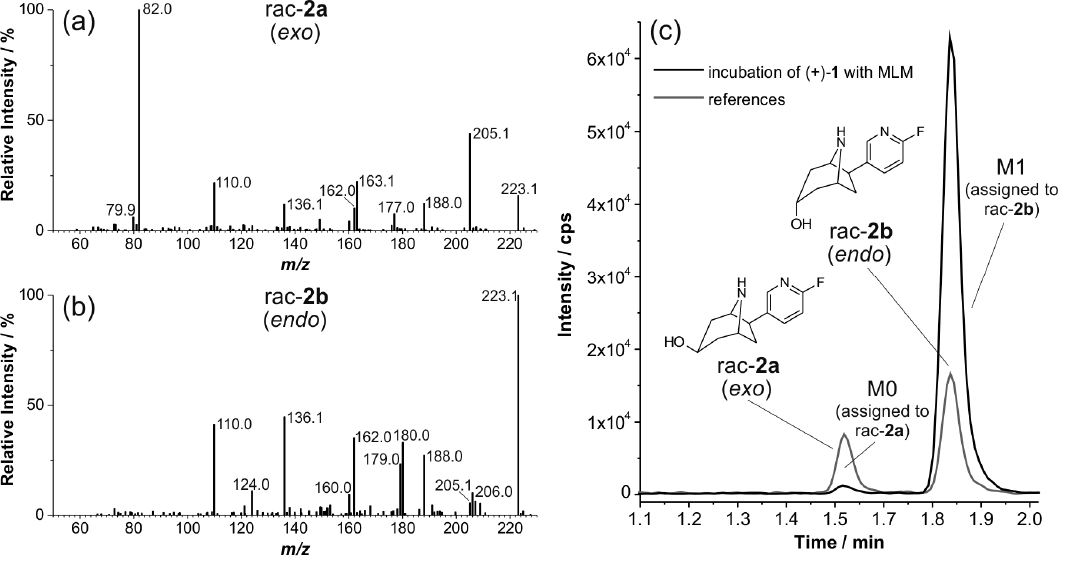
Figure 7. Enhanced product ion (EPI) spectra of: ( a ) rac - 2a ; and ( b ) rac - 2b (products of m / z 223.1, CE 33, CES 0). ( c ) Details of multi reaction monitoring (MRM) chromatograms (223.1/110.0) of an extract resulting from incubation of (+)- 1 with mouse liver microsomes (MLM) (37 °C, 90 min) and a mixture of the references rac - 2a and rac - 2b .